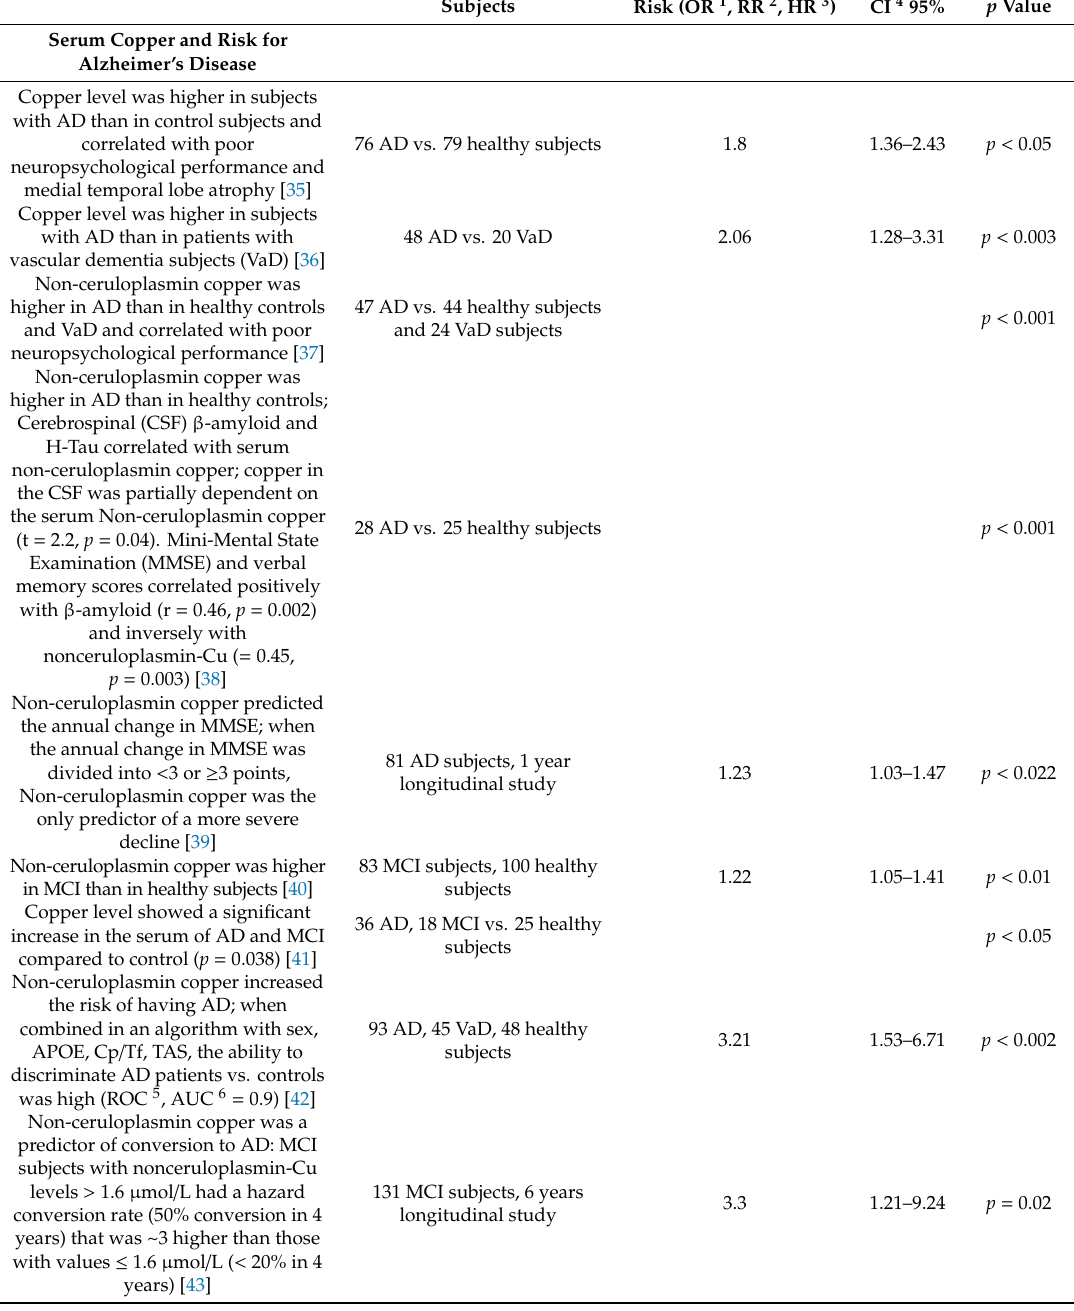
Table 1. Clinical studies analyzing the copper and ATP7B link to Alzheimer’s disease risk and the association with the subjects’ clinical